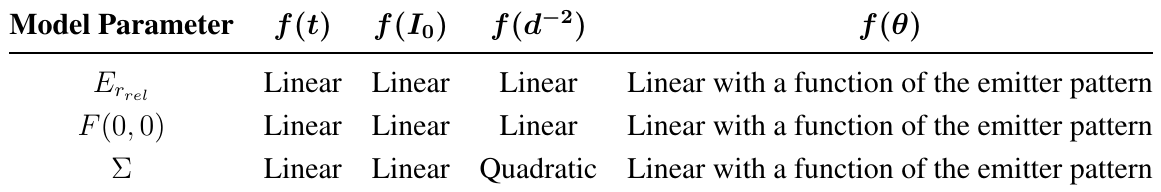
Table 1. Summary of parameter behaviors used to define the proposed models for camera-to-IRED distance estimation method. The final expression for each